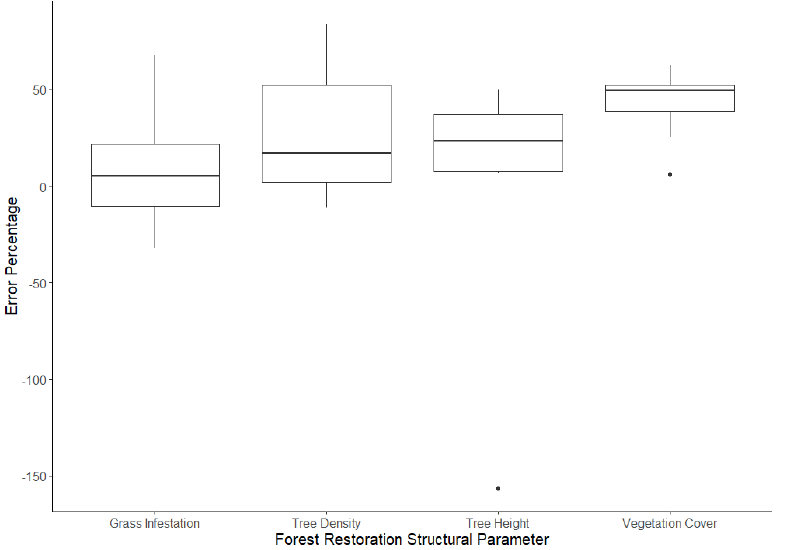
Figure 9. FR structural parameters of the stretches with different FR success varied from the fieldwork reference value, except Vegetation Cover. A variation in Tree Density and non-variation of Vegetation Cover suggest small tree crowns in